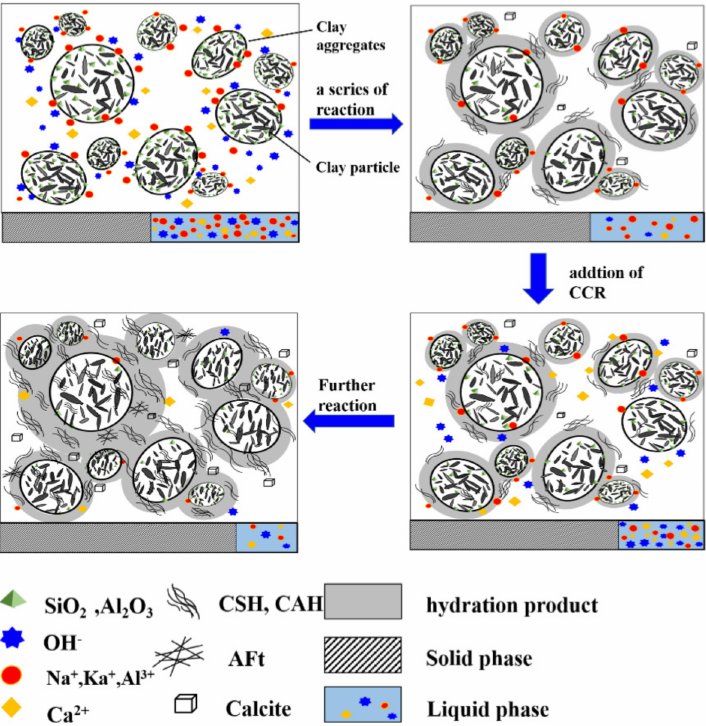
Figure 16. The solidification mechanism of